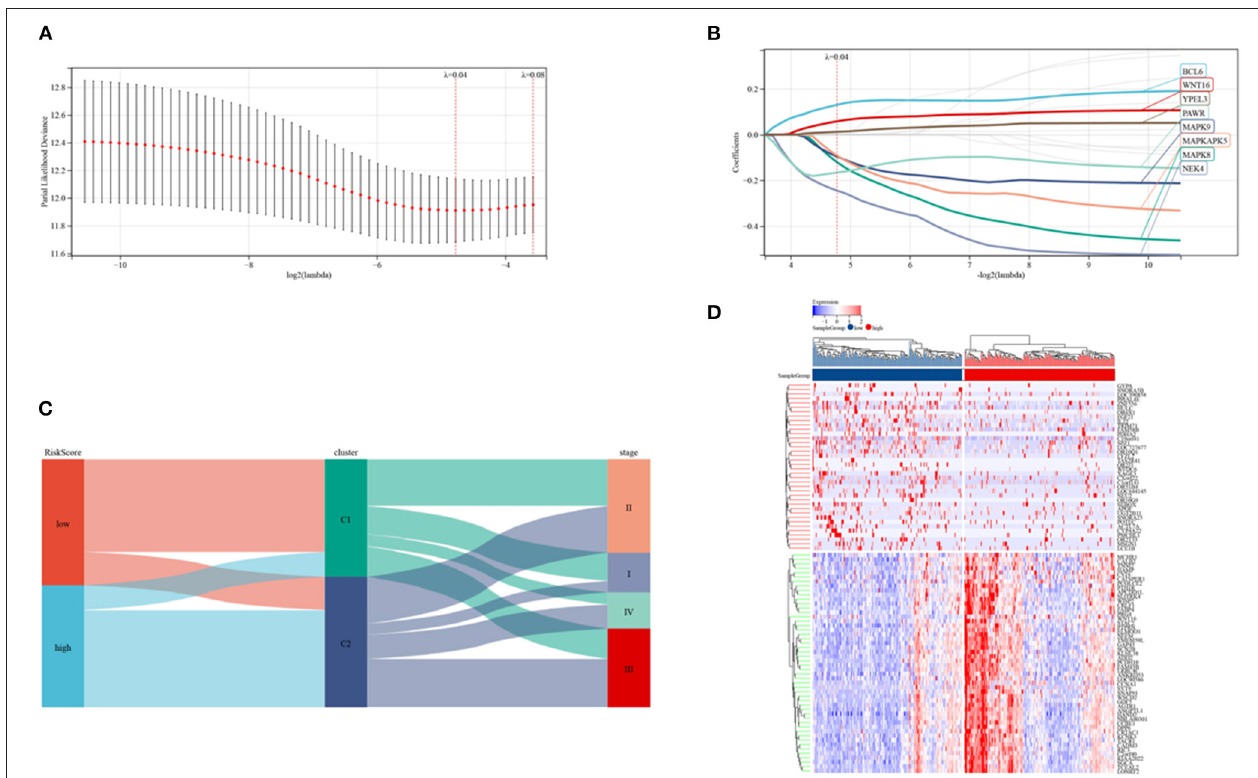
FIGURE 6 | Establishment of a risk model in the TCGA cohort. (A,B) LASSO regression analyses and partial family deviance of the prognostic genes. (C) Alluvial plot of sub-type dispersion in groups with various SRG risk scores, clusters and CRC stages. (D) Heatmap of the top 50 DEGs in the low and high-risk groups.